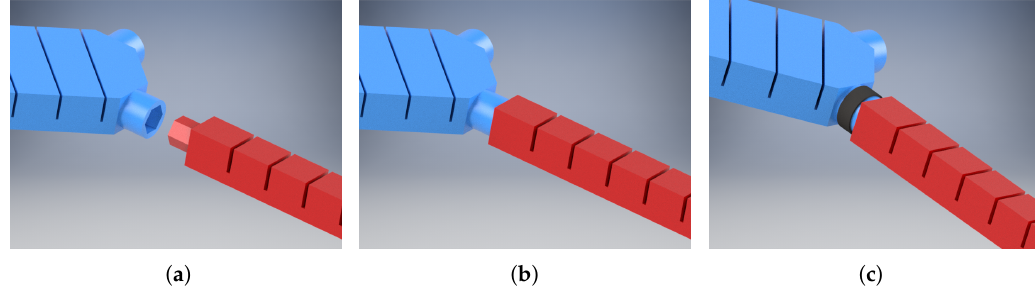
Figure 1. CAD model of a frictional connection: ( a ) unconnected; ( b ) connected; and ( c ) with additional elastic ring (blue: main body; red: